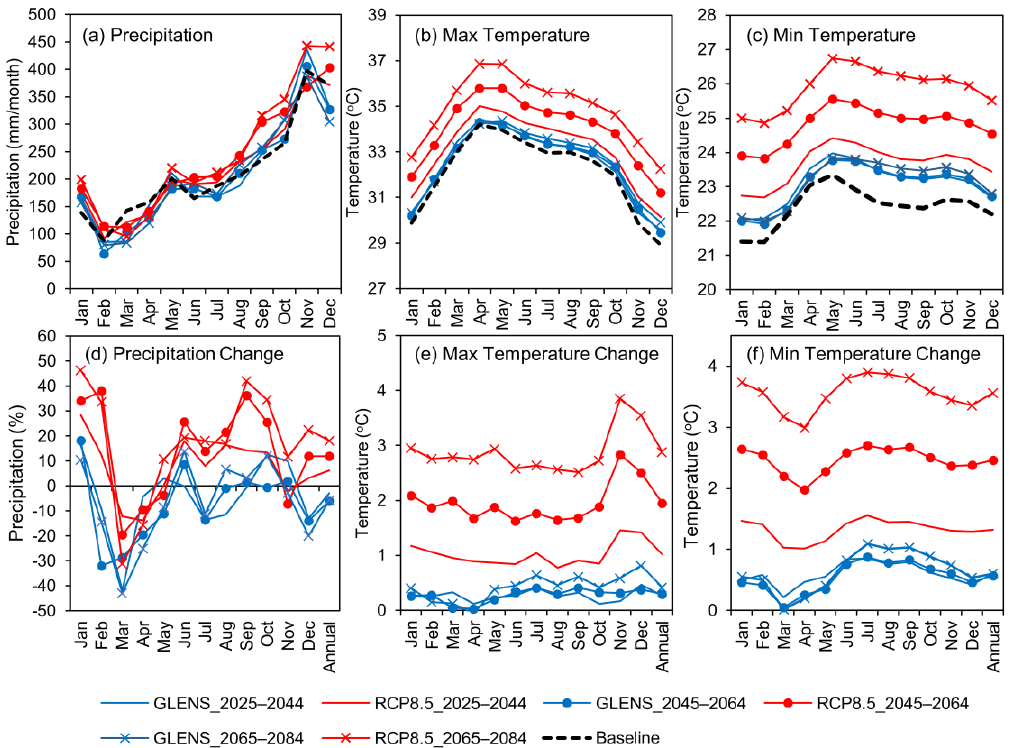
Figure 5. Comparison of climatology and relative changes of monthly ( a , d ) precipitation, ( b , e ) mean maximum temperature and ( c , f ) mean minimum temperature of the Kelantan River Basin between the historical (1985 – 2004) and future periods (2025 – 2044, 2045 – 2064 and 2065 – 2084) under the RCP8.5 and GLENS scenarios.